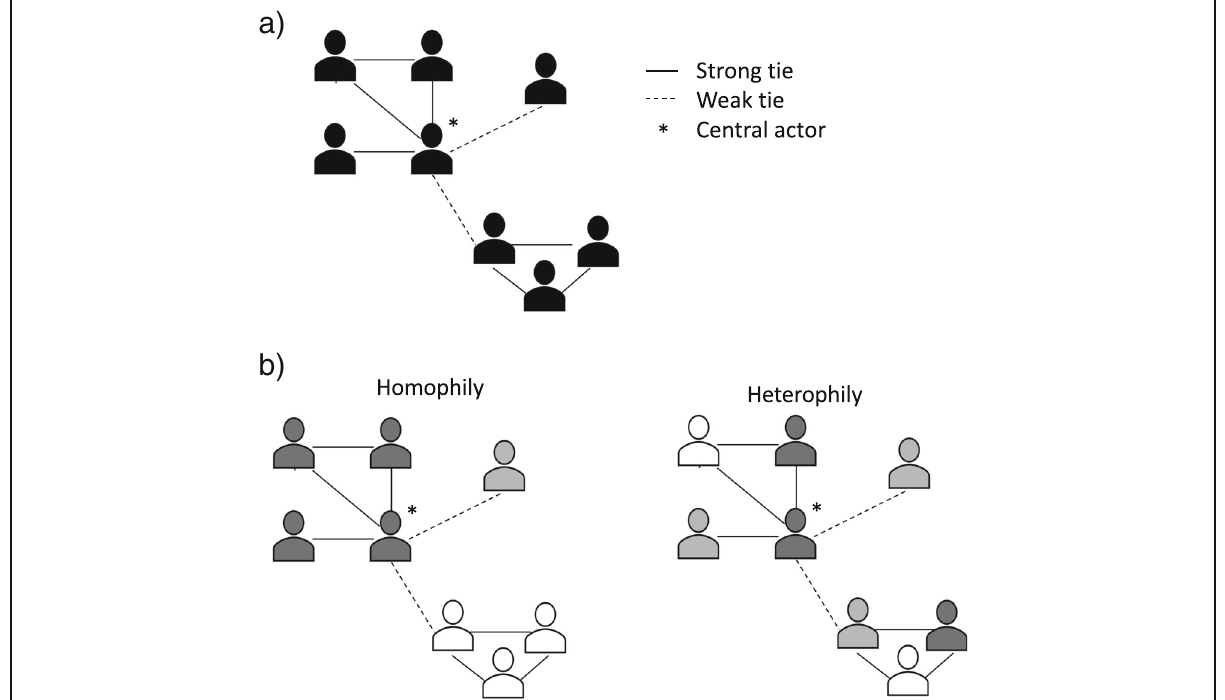
Fig. 1 Social network characteristics. a Type of tie strength and central actor. b Diversity of